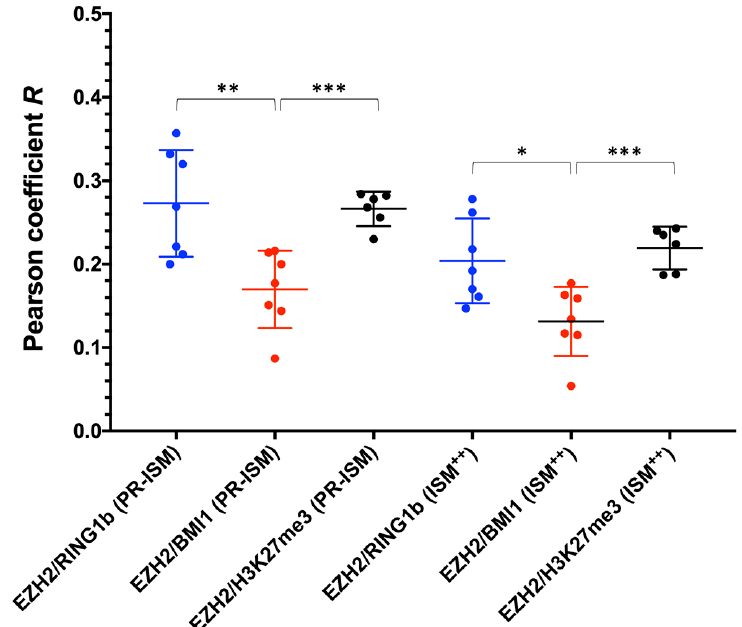
Figure 4. Pearson colocalization coefficients ( R ) of EZH2/RING1b (blue), EZH2/BMI1 (red), and EZH2/H3K27Me3(black) in HCC827 cells as determined by ISM. EZH2/RING1b: R = 0.27 ± 0.02 (PR-ISM), R = 0.20 ± 0.02 (ISM ++ ); EZH2/BMI1: R = 0.17 ± 0.02 (PR-ISM), R = 0.13 ± 0.02 (ISM ++ ); EZH2/H3K27me3: R = 0.27 ± 0.01 (PR-ISM), R = 0.22 ± 0.01 (ISM ++ ); values expressed as average ± SEM, * p < 0.05, ** p < 0.01, *** p < 0.001.